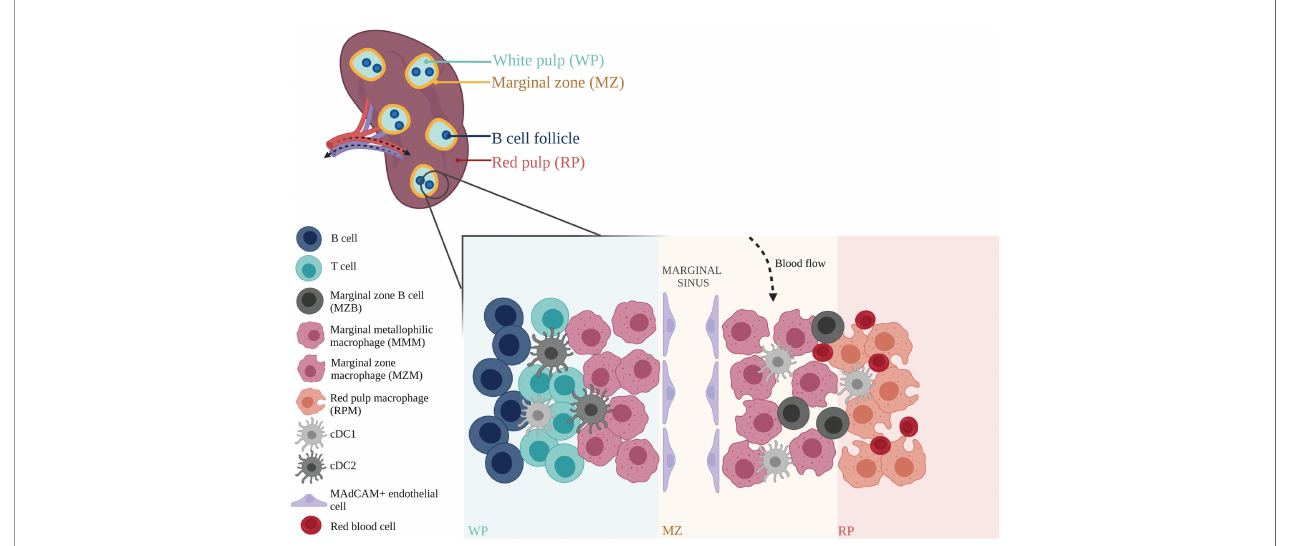
FIGURE 2 | Anatomical structure and organization of mouse spleen. The splenic arterial network functions to fi lter blood and maintain erythrocyte homeostasis. Arterial blood, arriving at the marginal zone (MZ), passes through the red pulp (RP) cords, and is monitored by red pulp macrophages (RPMs) that survey for blood-borne antigens (78). Blood is recollected in sinuses before exiting the spleen through the efferent vein for return to the systemic circulation (79, 80). Within the spleen, adaptive immune responses to incoming systemic antigens are initiated in the white pulp (WP) which are largely driven by T and B cells (81, 82). Circulating lymphocytes arriving at the spleen may exit the bloodstream and enter the WP via the MZ (77). Marginal zone macrophages (MZMs) and marginal metallophilic macrophages (MMMs) are involved in the clearance of apoptotic cells, and maintenance of immune tolerance (83). Their functions are mediated by dendritic cell subsets, cDC1 and cDC2, which present antigens to T cells, and marginal zone B cells (MZBs) that help synchronize immune responses between the adaptive and innate arms (73, 84). This immune network is closely supported by stromal cells such as MAdCAM + endothelial cells that line the marginal sinus, and help mediate tissue homeostasis (77). Figure was created with